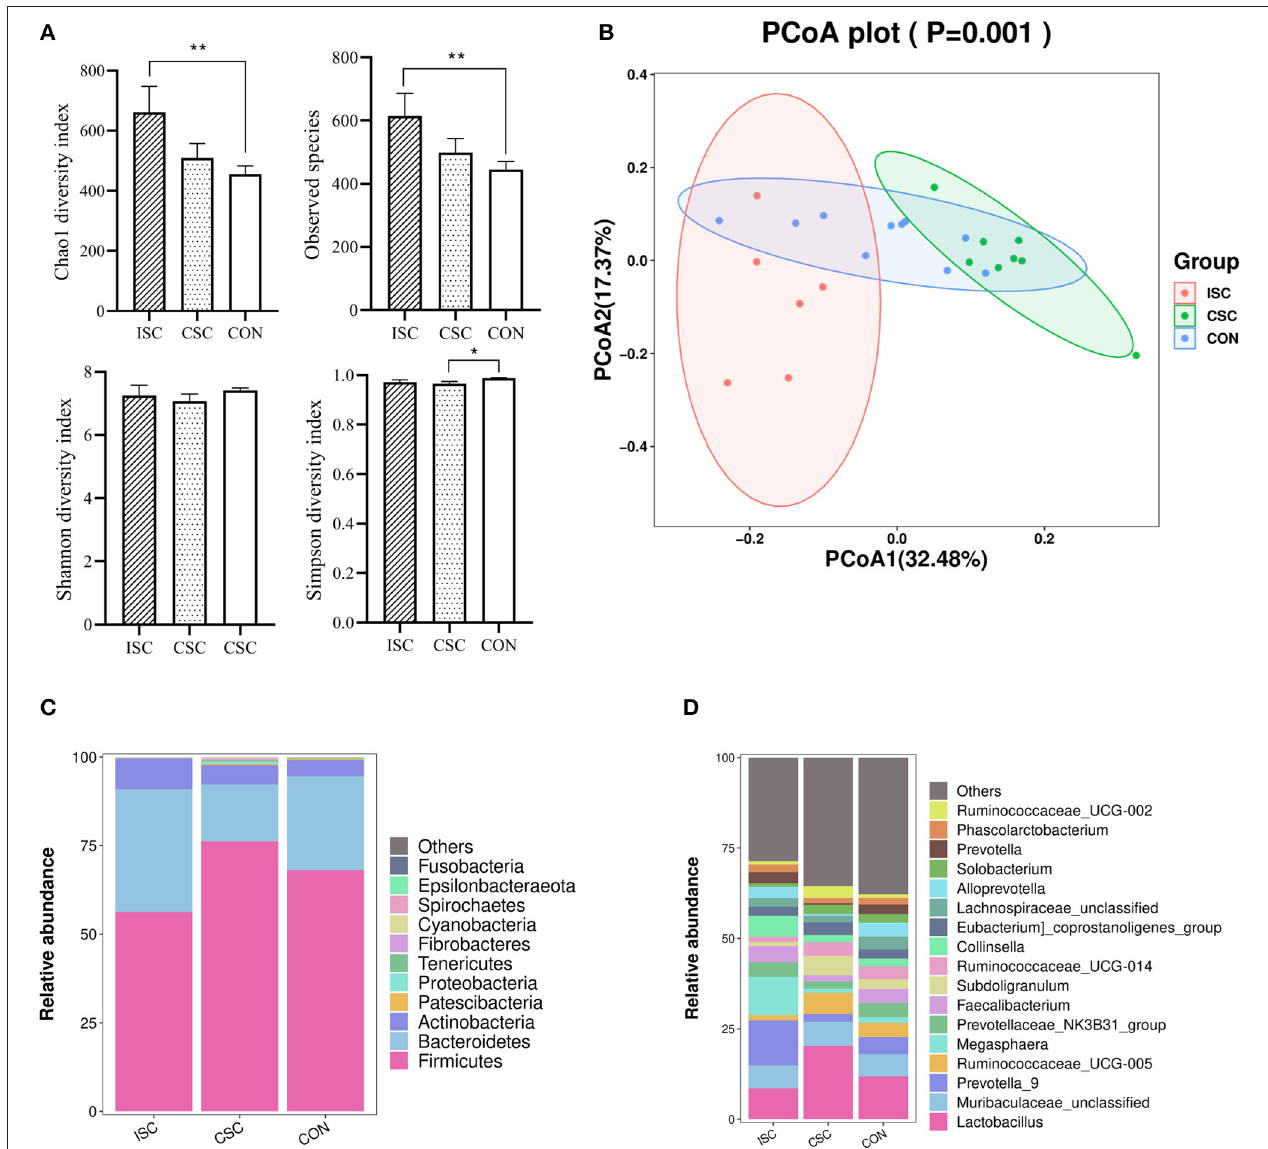
FIGURE 2 | The fecal microbial diversity and taxa in piglets. (A) Alpha diversity of the fecal microbiota containing Chao1, observed species, Shannon, and Simpson. * p < 0.05, ** p < 0.01; (B) principal coordinate analysis (PCoA, Bray–Curtis distance) of the fecal microbes. (C) Fecal microbial composition at the phylum level. (D) Fecal microbial composition at the genus level. ISC, intermittent social contact; CSC continuous social contact; CON, control.